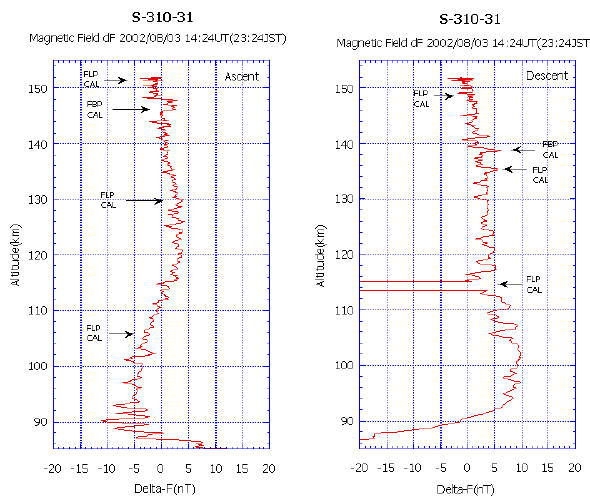
Fig. 8. Magnetic field fluctuation observed with magnetic field mea- surement (MGF) on board the S-310-31 rocket. Black arrows indi- cate the interference from the calibration signals of other instru- ments on board the same rocket.